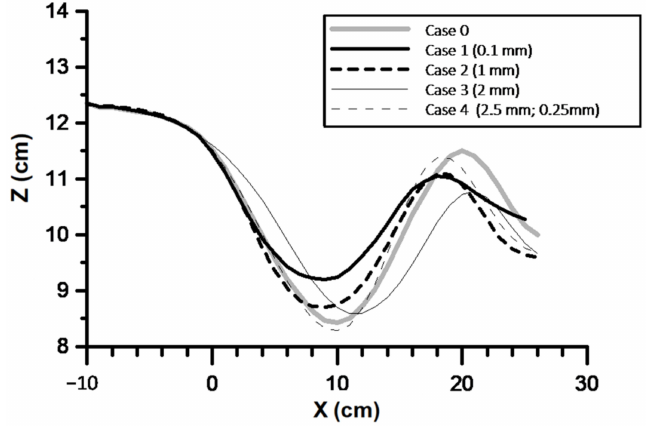
Figure 13. Response of water surface due to different strip sizes.